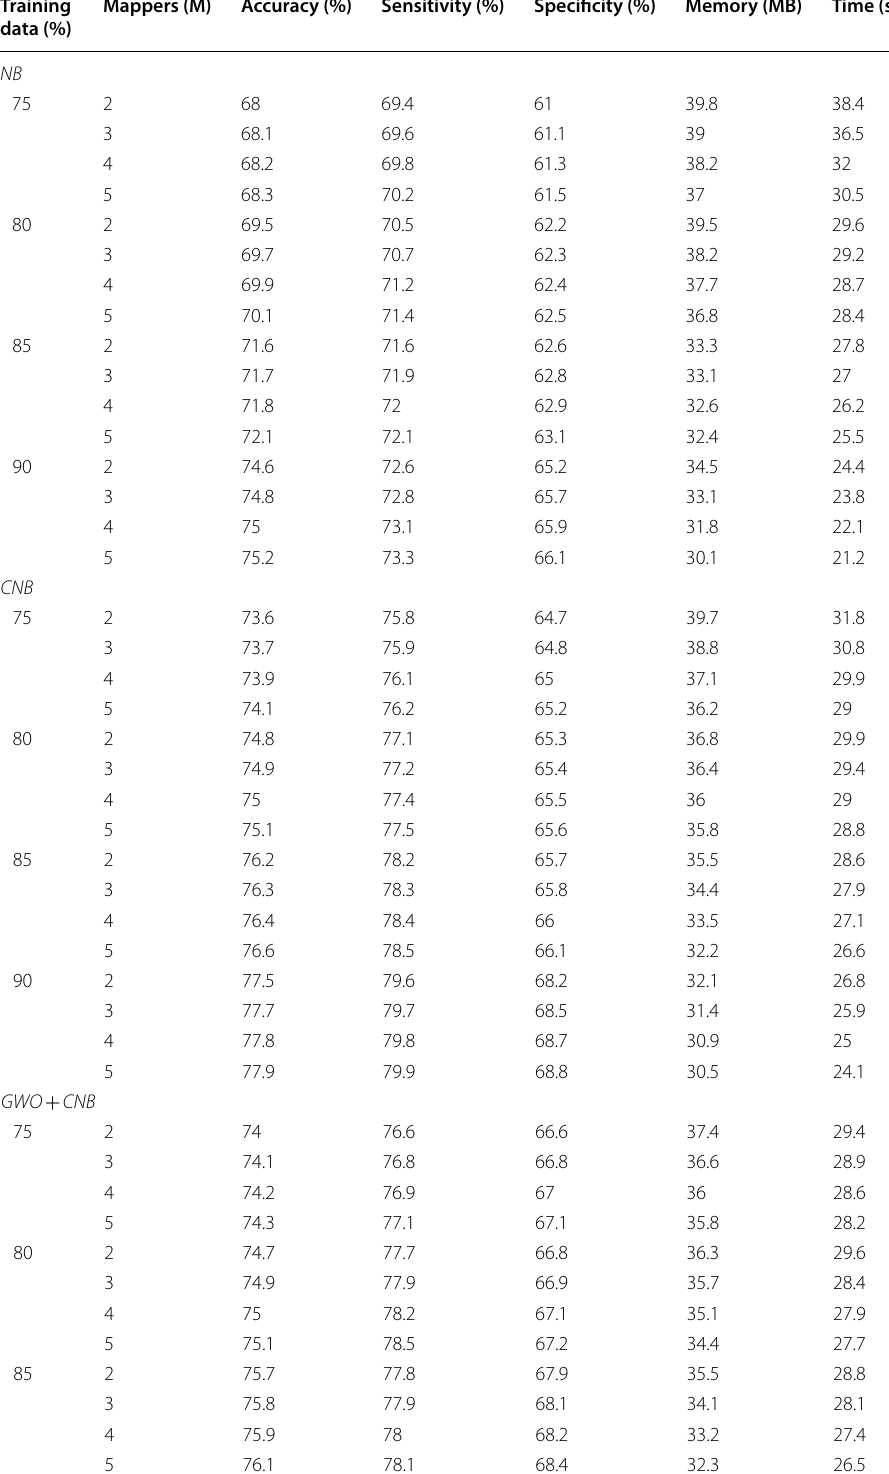
Table 2 A nalysis of CNB and CGCNB Training data